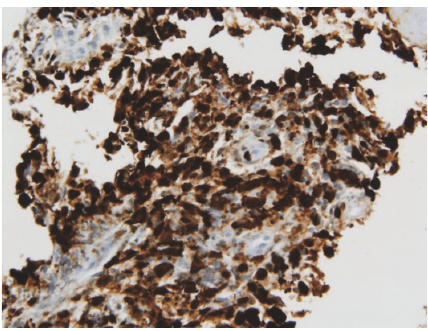
Figure 2: Immunohistochemistry positive for S-100 consistent with metastatic melanoma.